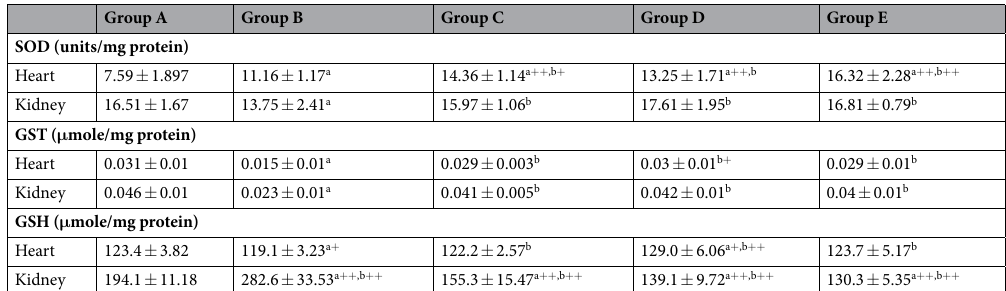
Table 3. Effect of pretreatment of CurNisNp on antioxidant systems in MI induced guinea pigs. Note; results in the table above are in Mean ± standard deviation of each group of five guinea pigs. a P < 0.05 compared with group A; a + P < 0.01 compared with group A; a ++ P < 0.001 compared with group A; b P < 0.05 compared with group B; b + P < 0.01 compared with group B; b ++ P < 0.001 compared with group